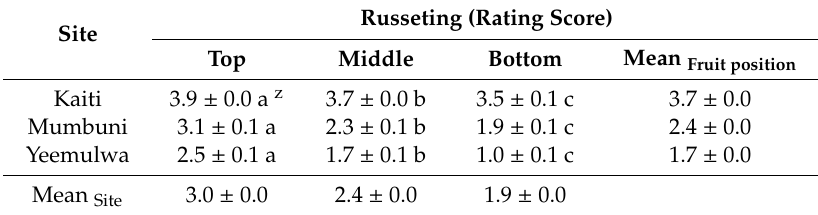
Table 4. E ff ect of fruit position within the tree canopy on russeting of ‘Apple’ mango in di ff erent sites. Fruit positions were: top ( > 2 m above the ground), middle (1–2 m), and bottom (0.5–1 m). Russeting was quantified using a five-score rating scheme. Score 0: 0% of the fruit surface area russeted; score 1: 1–10% russeted area; score 2: 11–25% russeted area; score 3: 26–50% russeted area; and score 4: 51–100% russeted area.